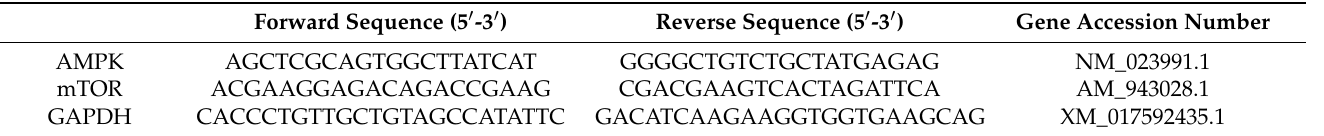
Table 1. Primer sequence of the examined